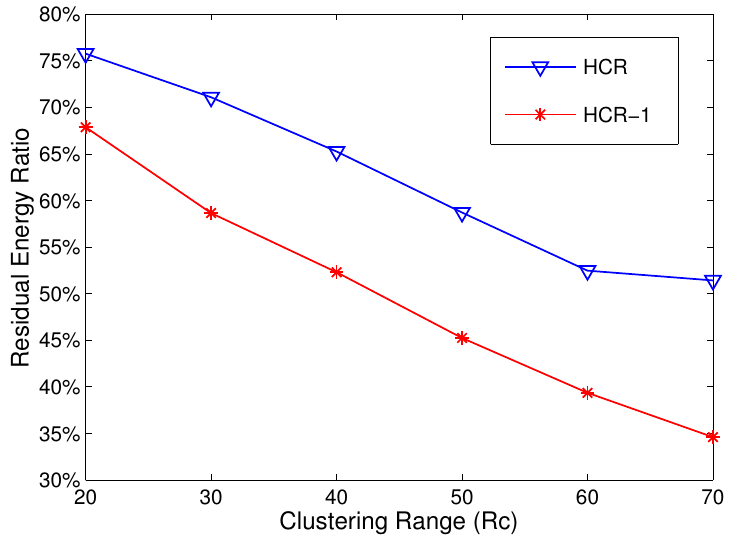
Figure 8. Residual energy ratio comparison with different R